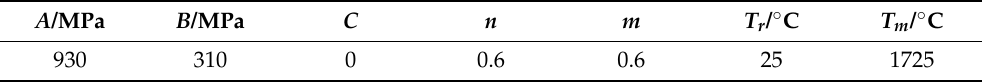
Table 1. Johnson-Cook constitutive model parameters for zirconia ceramics [22]. A